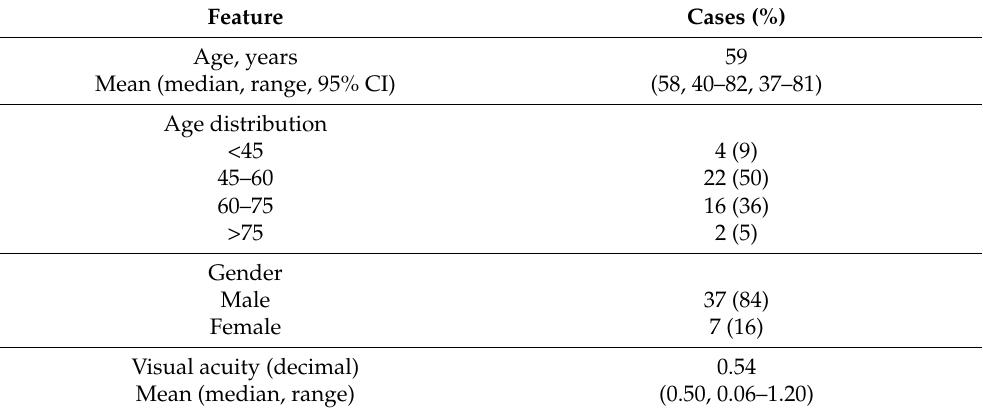
Table 1. Choroidal Neovascularization in Central Serous Chorioretinopathy: Initial Presentation (N =